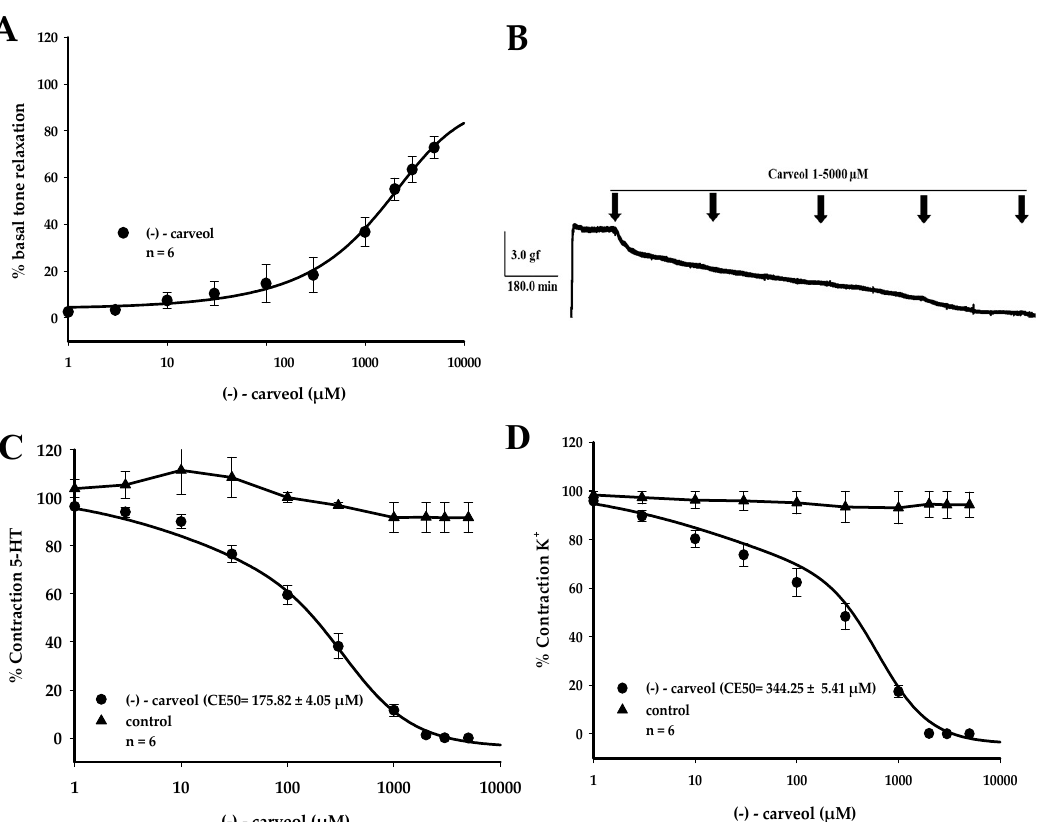
Figure 2. Relaxant e ff ect of ( − )-carveol in the HUA on contractions sustained by 5-HT and KCL (60 mM). ( A ) Representative graph of the e ff ect of ( − )-carveol on the HUA basal tone. ( B ) Original layout showing the relaxant e ff ect of ( − )-carveol (1–5000 µ M) on the spontaneous basal tone in the HUA. ( C ) Representative graph of the e ff ect of ( − )-carveol on contractions sustained by 5-HT (10 µ M). ( D ) Representative graph of the e ff ect of ( − )-carveol on contractions sustained by KCl (60 mM). Values are expressed as the mean ± SEM; n = 6 ( p < 0.05, one-way ANOVA followed by